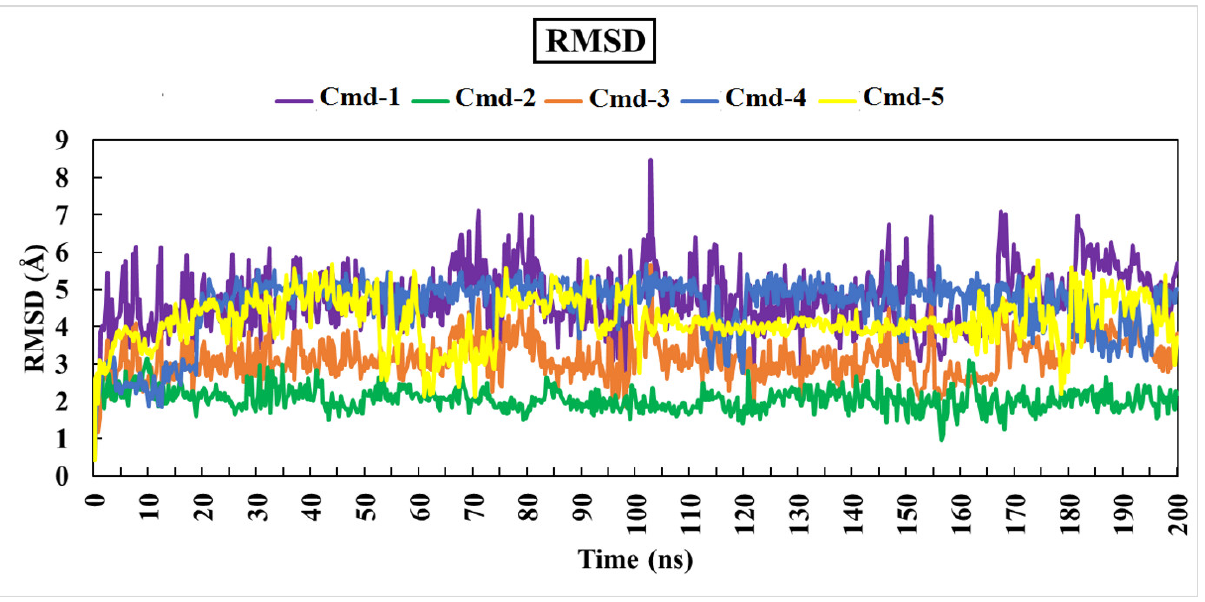
Figure 5. Variations in the RMSD values for the studied ligands over the course of the molecular dynamics simulation.